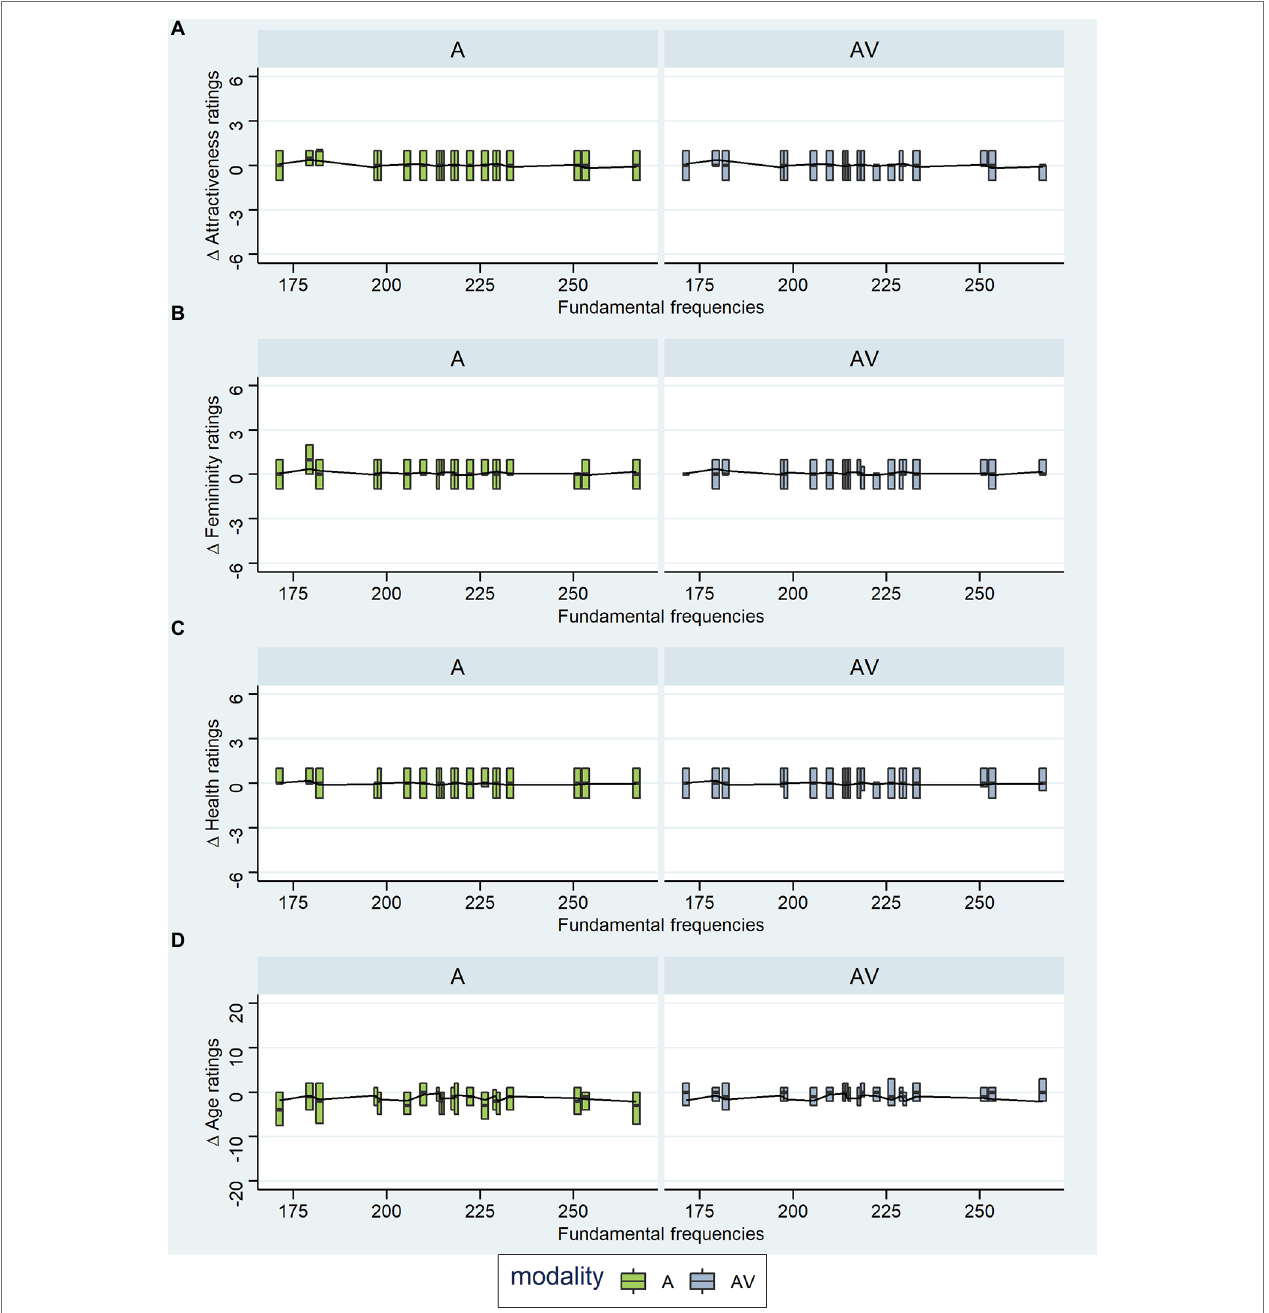
FIGURE 6 | Exploratory Analyses: Rating Differences for Different Fundamental Frequencies. A and AV are the experimental blocks, whereby A = ratings of voices and AV = ratings of faces. Panel (A) shows rating differences for attractiveness ratings, (B) for femininity ratings, (C) for health ratings, and (D) for age ratings (in years). Whiskers and outliers were removed from the